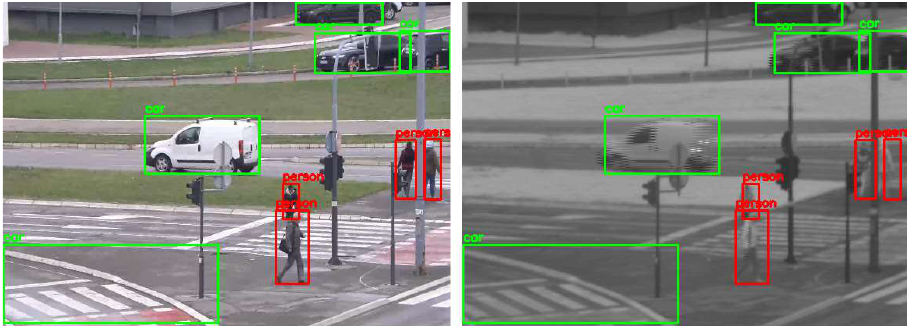
Figure 10. An example of incorrect car detection mapping due to false detection on the color image. 3. Detections of objects on the color image that are not visible on the SWIR image due to the nature of the SWIR sensor and should not be part of the SWIR training dataset— Figure 11.